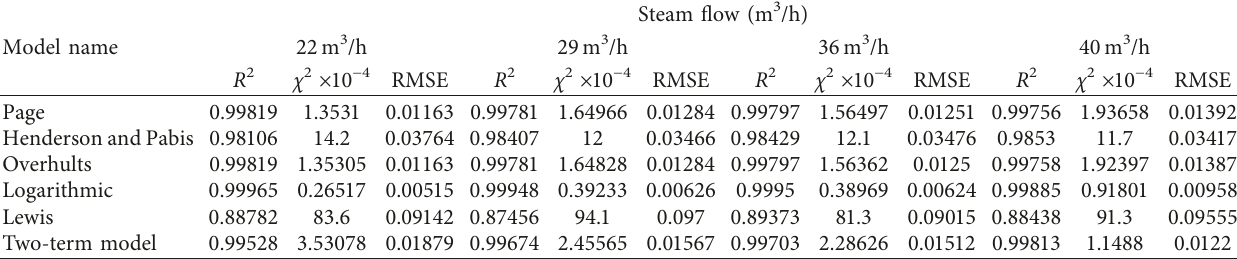
Table 7: Fitting results of drying stage of sludge superheated steam drying under different steam flow.